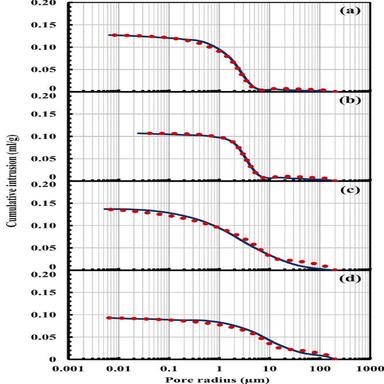
Pore cumulative curves. Comparison between MIP data (continuous lines) and IFU modelling (dotted lines). Curves are given for B-IS6 (a), B-IS7 (b), B–SO6 (c) and B–SO7 (d) samples. IFU parameters are reported in.